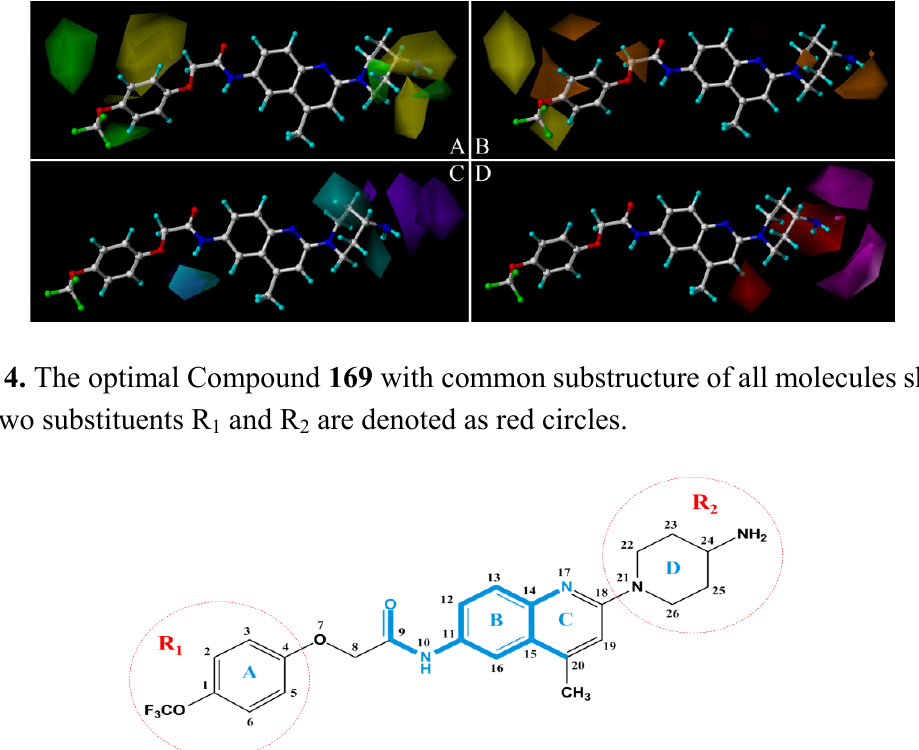
Figure 3. CoMSIA coeff*stddev contour maps in combination with Antagonist 169 . ( A ) Steric fields: green contours represent regions where bulky groups increase the activity, while yellow contours represent regions where bulky groups decrease the activity; ( B ) hydrophobic fields: yellow contours indicate regions where hydrophobic feature favors the activity, while orange contours indicate where hydrophobic feature disfavors the activity; ( C ) H-bond donor fields: cyan contours indicate where H-bond donors are beneficial for the activity, purple contours indicate where H-bond donors are detrimental for the activity; ( D ) H-bond acceptor fields: magenta contours indicate regions where H-bond acceptors on the receptor promote the affinity, while red contours indicate regions where H-bond acceptors on the receptor demote the affinity.